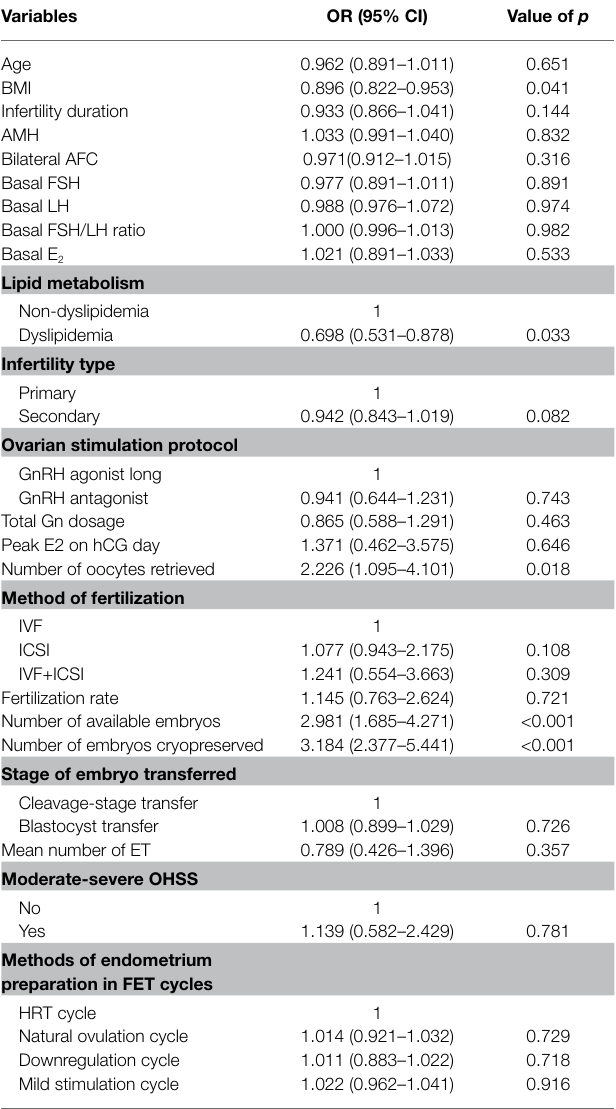
TABLE 4 | Results of univariate analysis for